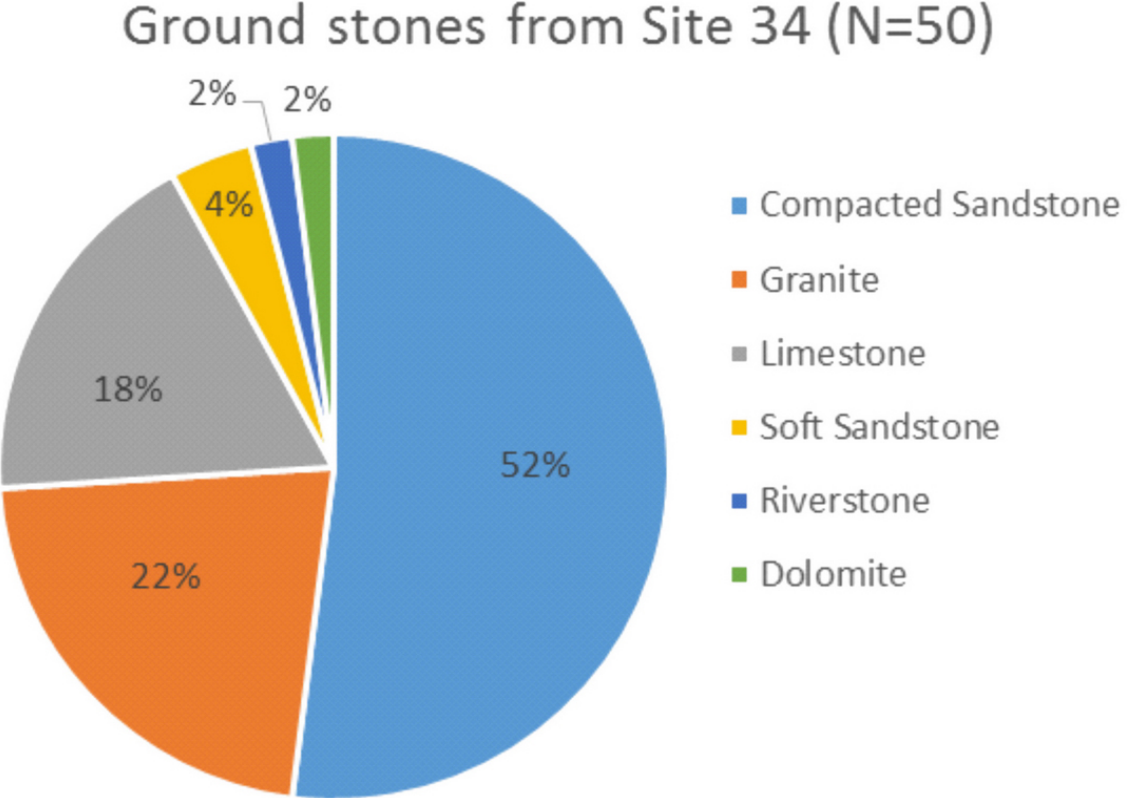
Figure 13. Distribution of ground stone rock types from Site 34